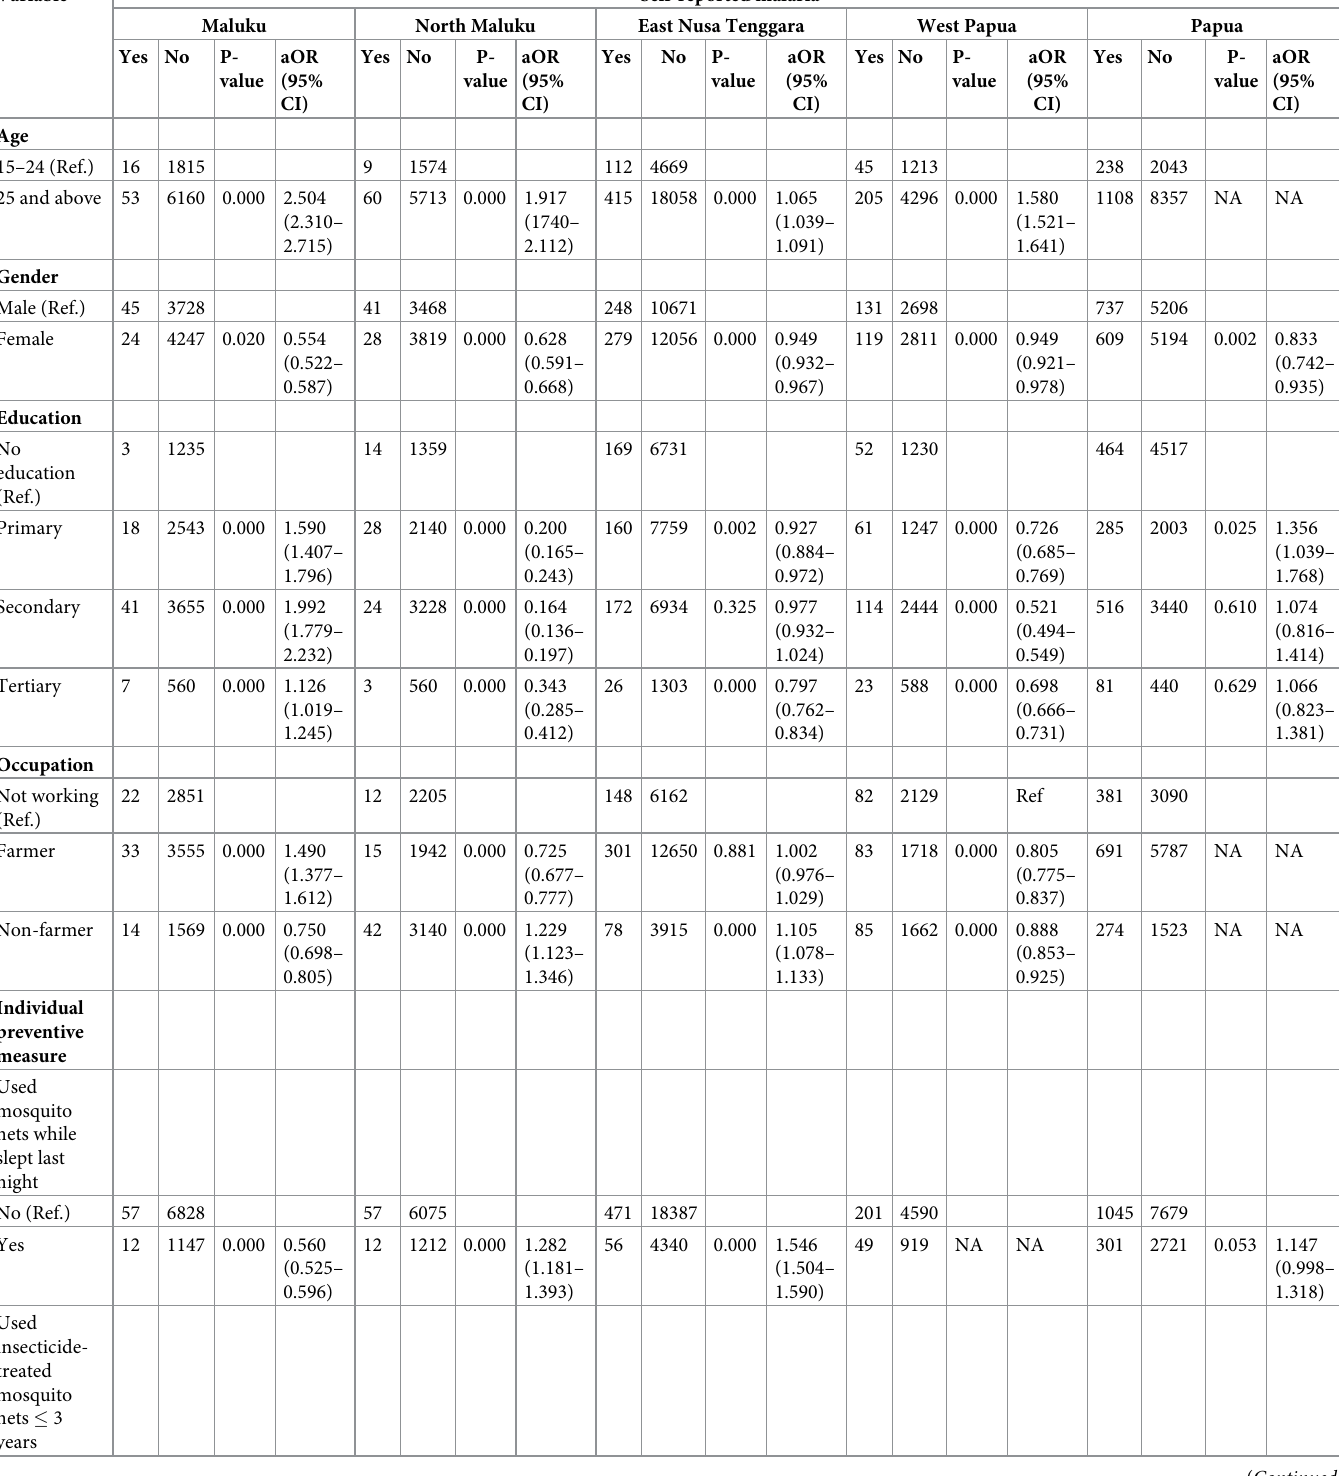
Table 3. Association between individual and household-level preventive practices and self-reported malaria among adults living in rural areas in five selected prov- inces in Indonesia.